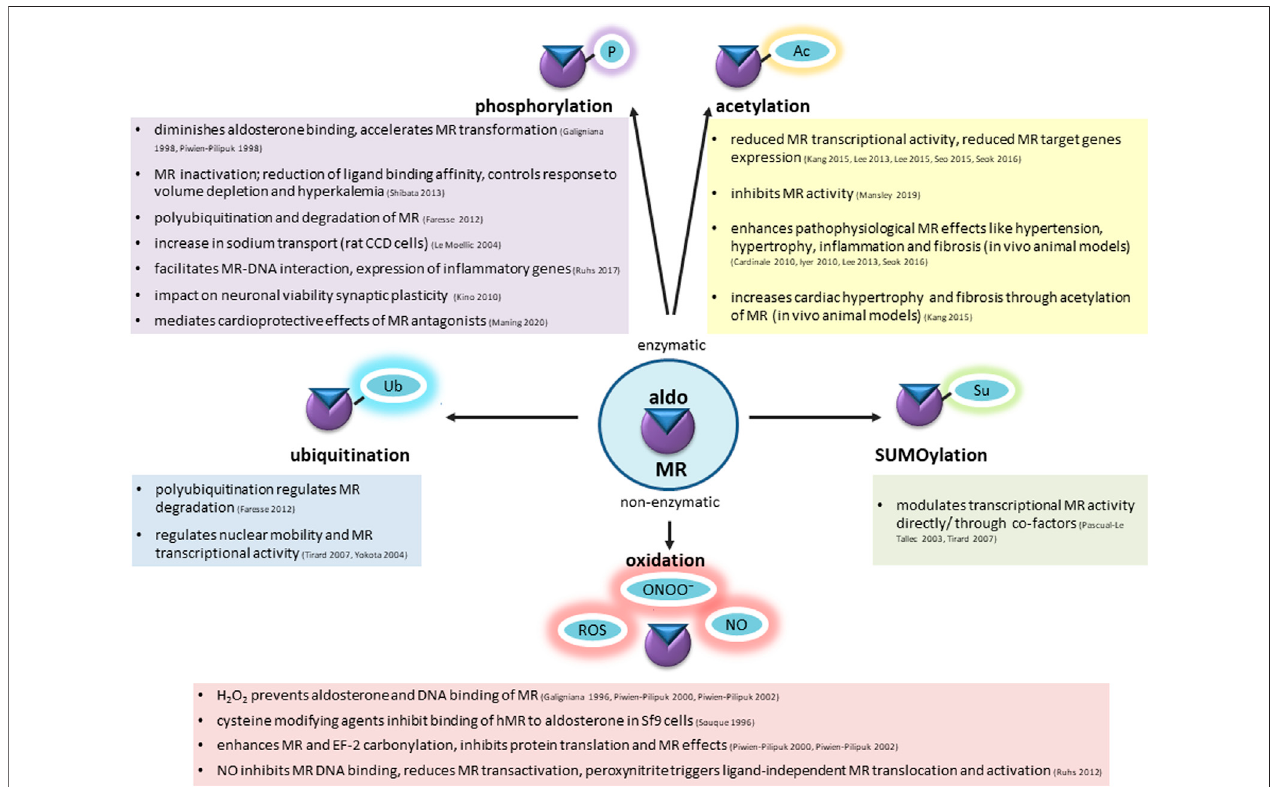
FIGURE 3 | Mineralocorticoid receptor undergoes enzymatic and non-enzymatic posttranslational modi fi cations, affecting the basal condition of the receptor, ligand binding, shuttling to the nucleus, DNA interaction and transactivation activity. Among enzymatic modi fi cations phosphorylation (P), acetylation (Ac), ubiquitination (Ub), SUMOylation (Su) has been well-described. Increased ROS and RNS production during aging causes non-enzymatic alterations. Possible consequences are summarized in this fi